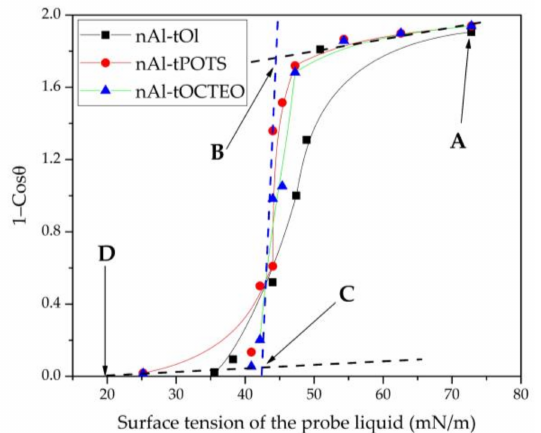
Figure 6. Wetting curves of the nanotextured aluminum surface in Zisman coordinates, characterized by specific points: A—water wetting; B—the repellence threshold; C—complete extrapolated wetting; D—complete wetting. (the blue dot line is tangent to the B-C segment, and the black dot line is tangent to the A-B and C-D curve